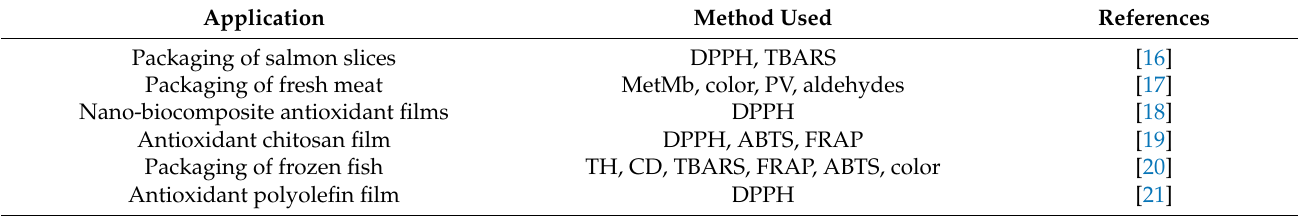
Table 2. Methods for assessing antioxidant activities in active packaging